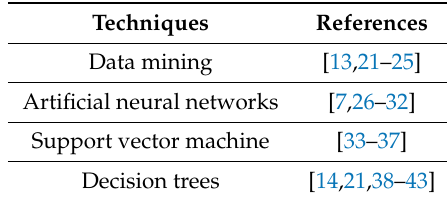
Table 1. References of DM techniques